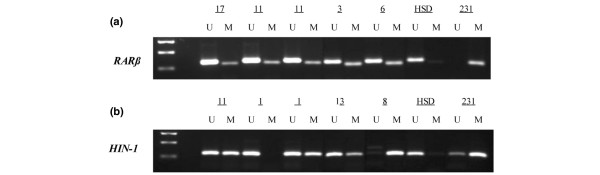
Representative methylation analysis of DL samples from BRCA carriers in whom aberrant methylation was found. (a) Hypermethylation of RAR-β found in ductal lavage (DL) samples from subjects 17, 11, 3 and 6. Replicate PCR experiments for subject 11, using DNA from the same duct, are shown to illustrate reproducibility. (b) Methylation analysis of HIN-1. Two different ducts for subject 1 are shown: the first is unmethylated (duct right 2a; see Figure 2) and the second shows hypermethylation of HIN-1 (duct right 1a). Subjects 11, 13 and 8 show aberrant methylation of HIN-1. In both panels, unmethylated control samples consisted of 1 mg/ml solutions of human sperm DNA (HSD), and methylated controls were 1 mg/ml solutions of DNA extracted from the MDA-MB-231 breast cancer cell line (231). Marker used is a 123bp DNA ladder - rungs represent 123bp, 246bp and 369bp. M, methylated; U, unmethylated.